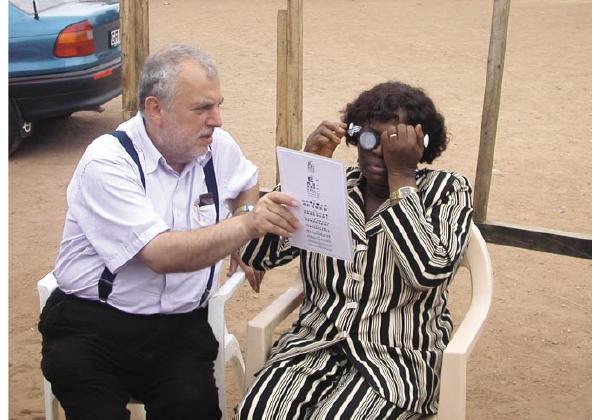
Figure 4. Professor Silver performing an Adspecs procedure on the head of Special Education, Agnes Addo – Mensah.